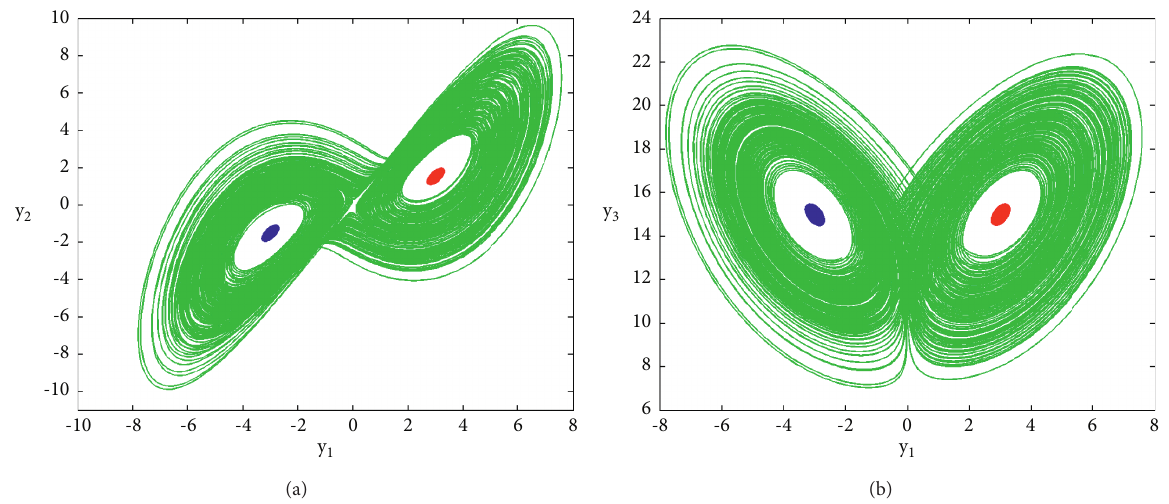
Figure 2: Hidden chaotic attractor (green plot) of system (4), with parameter selection A corresponding to Eq ( 2 ) � ( 3 , 1 . 5 , 15 , 0 ) (red plot) and one-point attractor corresponding to Eq ( 3 ) � (− 3 , − 1 . 5 , 15 , 0 ) (blue plot): (a) y y -view. view; (b) y 1 3